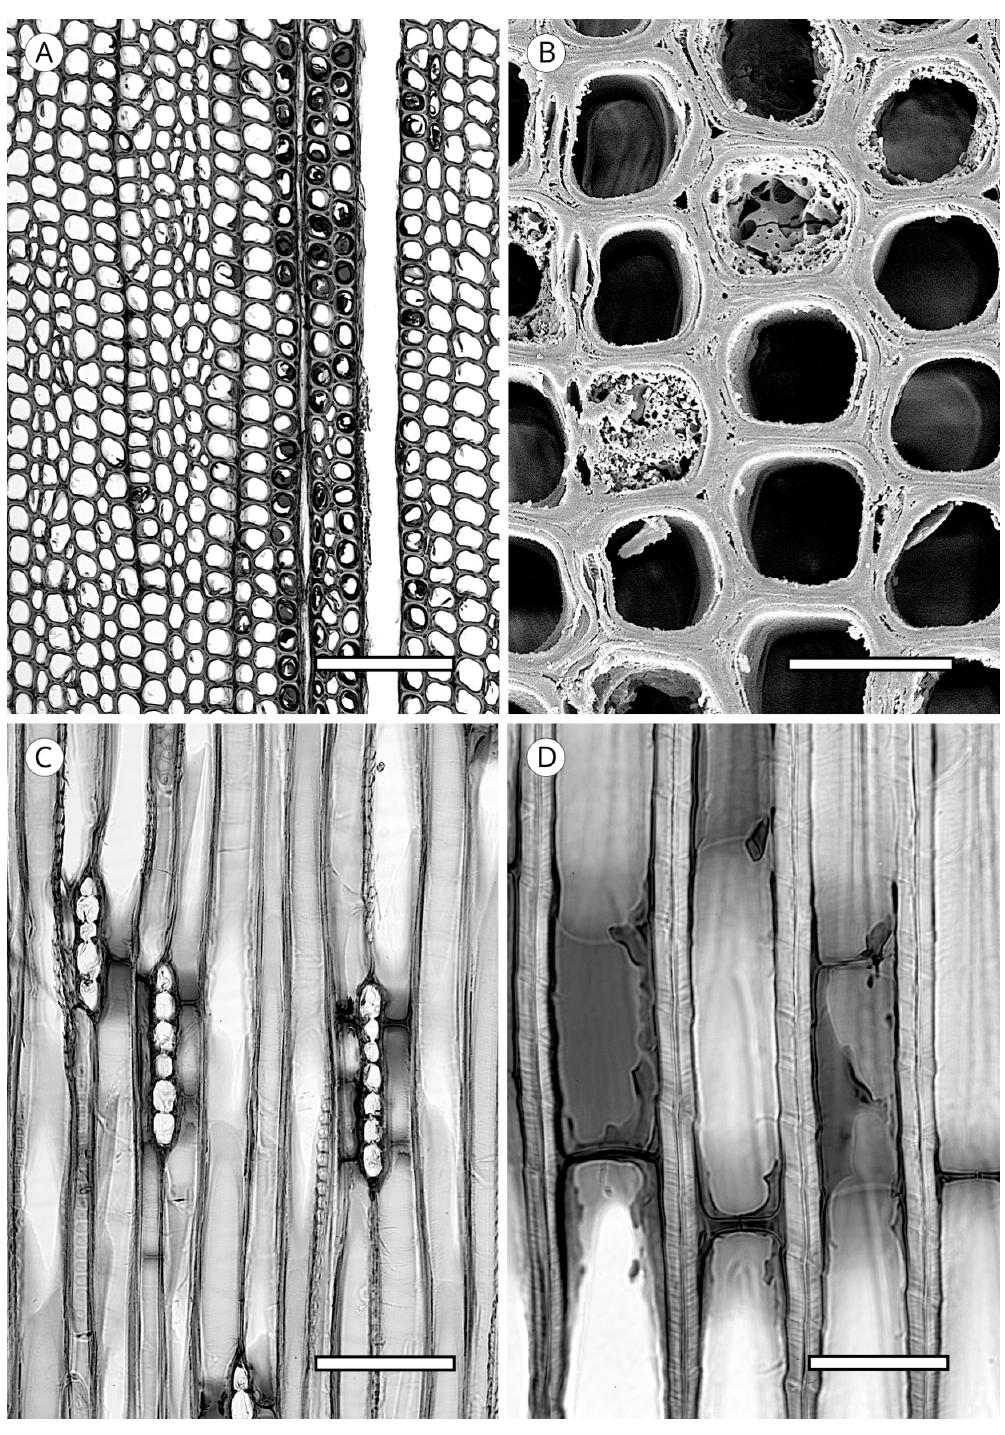
Figure 19. Organic deposits. ( A , C , D ) Araucaria columnaris (G.Forst.) Hook.; ( B ) Callitris endlicheri (Parl.) F.M.Bailey (SEM). Scale bars. ( A ) = 250 μ m; ( B , D ) = 50 μ m; ( C ) = 150 μ m. (Parl.) F.M.Bailey (SEM). Scale bars. ( A ) = 250 µ m; ( B , D ) = 50 µ m; ( C ) = 150 µ